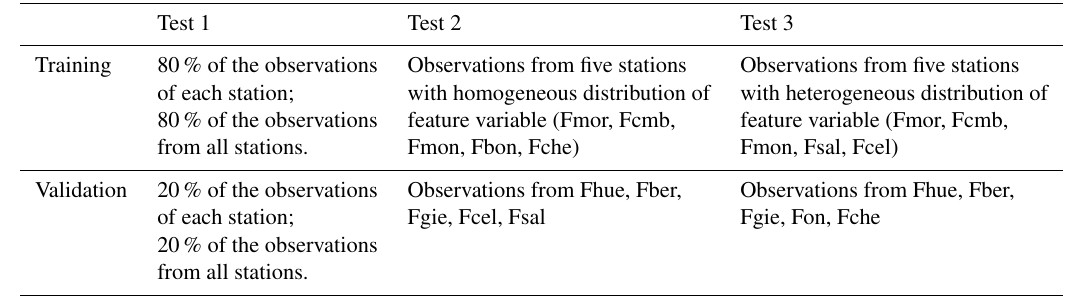
Table 2. Summary of three tests conducted to verify the performance of the spatiotemporal prediction of the DTM. Test 1